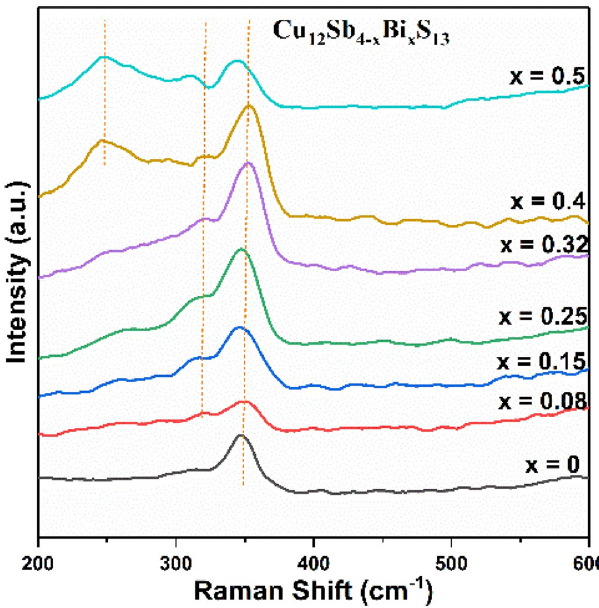
Figure 12. Raman spectra of Bi-doped tetrahedrite Cu 12 Sb 4−x Bi x S 13 (x = 0.08, 0.15, 0.25, 0.32, 0.4 and